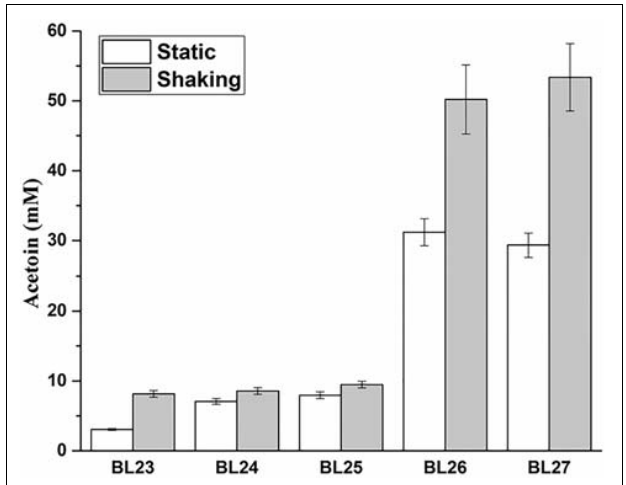
FIGURE 5 | The acetoin production in strains BL23, BL24, BL25, BL26, and BL27 grown under shaking and static conditions for 24 h. Results are the averages from three independent experiments with standard deviations indicated by error